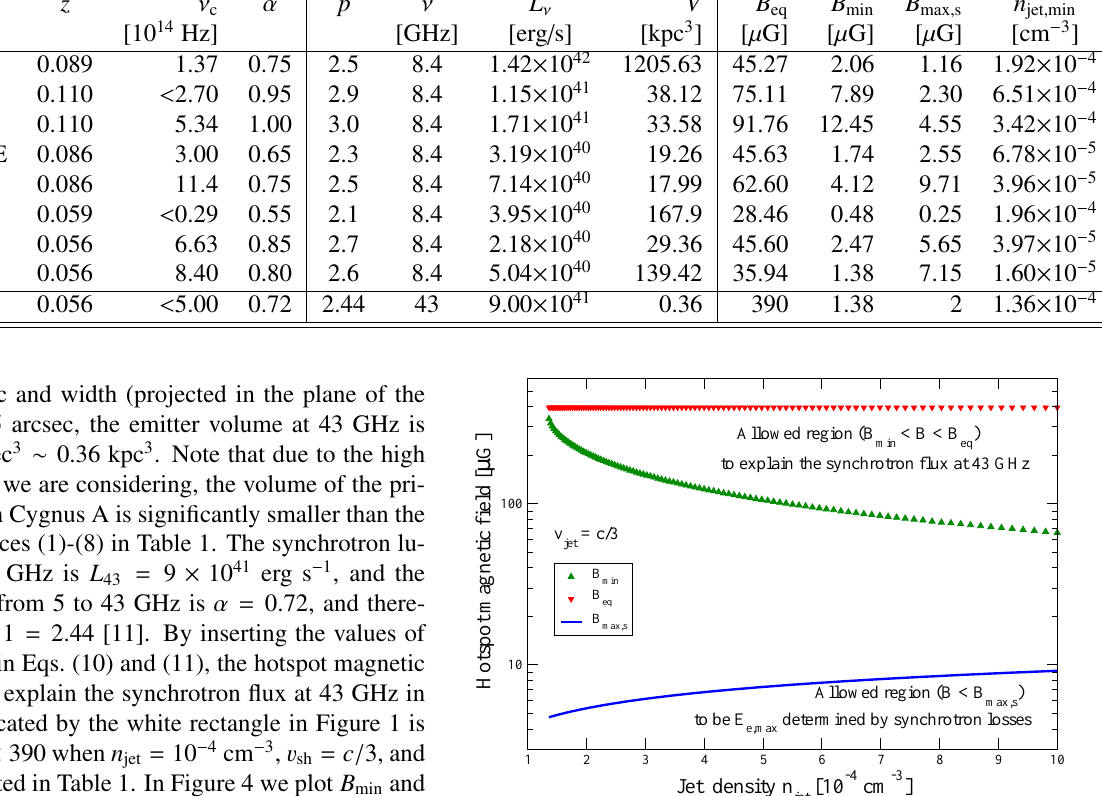
Table 1. Physical parameters of the sources considered in this contribution. This table is adapted from [23]. Source z